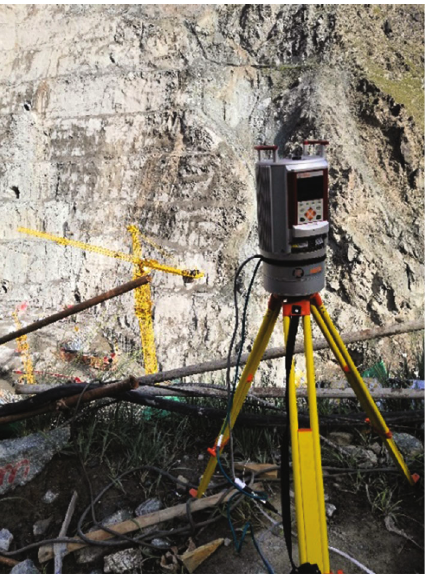
Figure 10: 3D laser scanner working diagram.